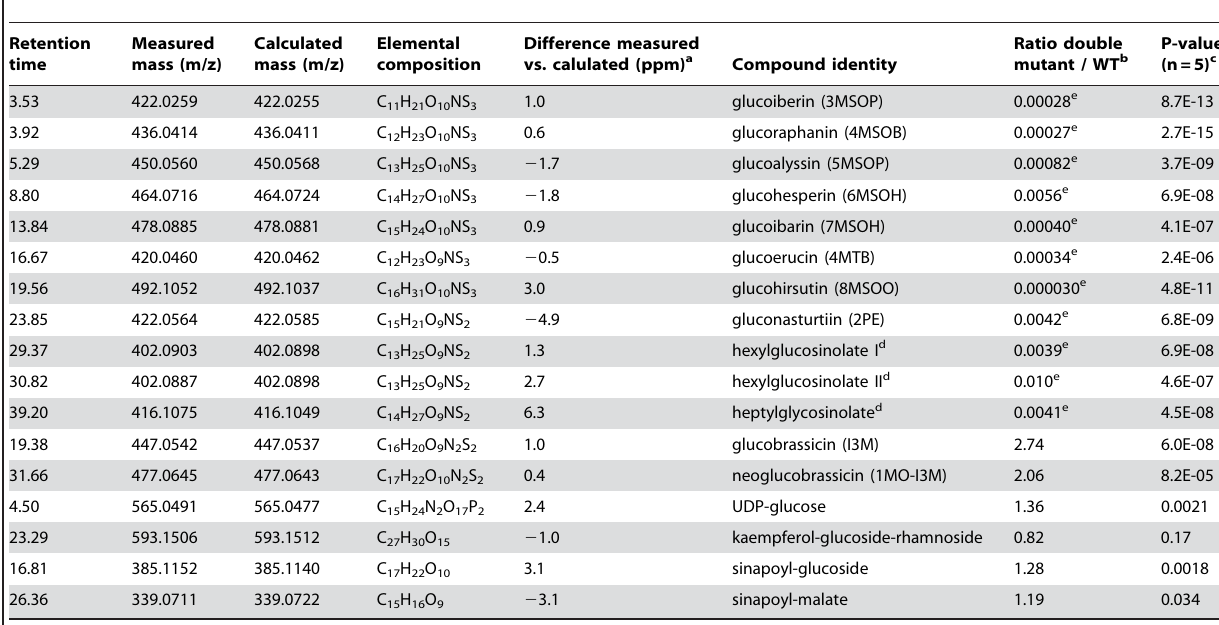
Table 1. Metabolites detected by LC-QTOF-MS (ESI negative mode) that were significantly different (student t-test, p , 0.05, n=5) between myb28myb29 double mutant and wild-type, and relative levels of some other relevant compounds.